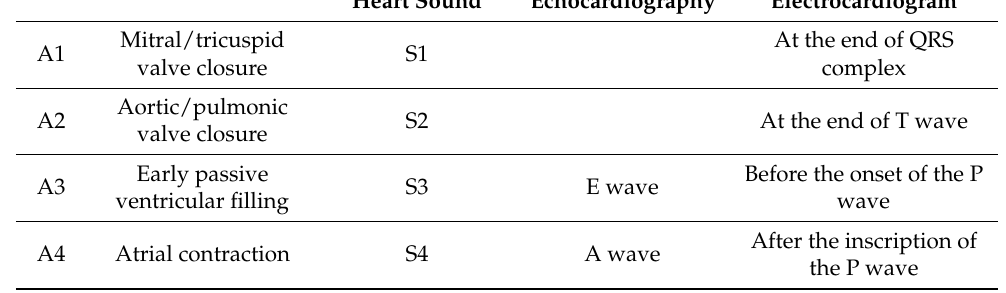
Table 1. Meanings of A1–A4 in relation to function, echocardiography, and electrocardiogram.